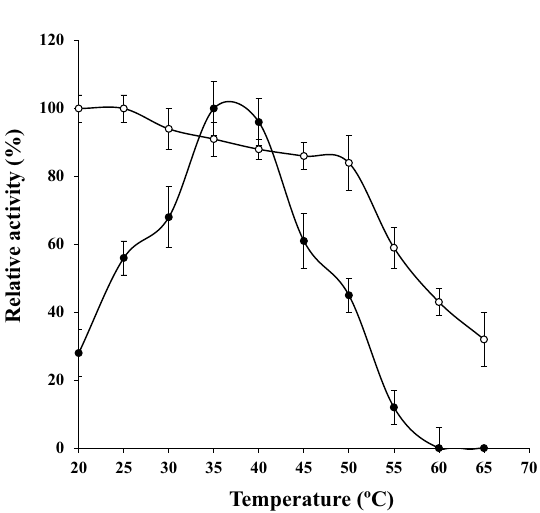
Figure 3. Impact of the temperature on both the proteolytic activity (- ● -) and the stability (- ○ -). The temperature impact on the enzymatic activity was tested at pH 7.0 with 0.2 M Tris–HCl buffer using the substrate azocasein. The temperature stability of the UcB5 was studied by its incubation without substrate in 0.2 M Tris–HCl (pH 7.0) for 60 min. By the end of the incubation, the remaining activity was assessed. There is a highly positive correlation between the enzyme activity and its thermal stability since the correlation coefficient r = 0.738**. The two-tailed P- value is given as 0.015, this yields a highly significant linear correlation. While there is a highly negative correlation between the enzyme stability and temperature cleared from the correlation coefficient r = − 0.915***. The two-tailed P- value is given as 0.000, this yields a very highly significant linear correlation. The estimated regression equation can be expressed as enzyme stability = 139.9–1.47